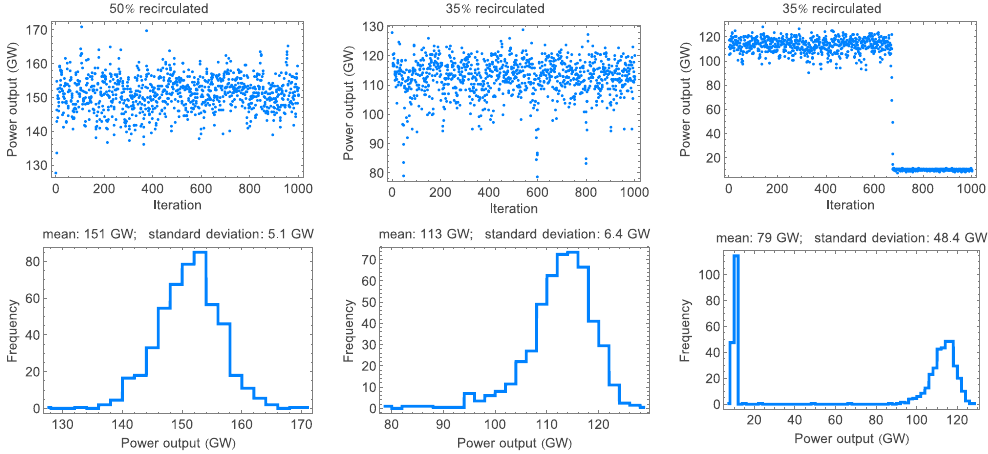
oscillations.FIG. 14. Example power output Monte Carlo simulations for 5% rms input current